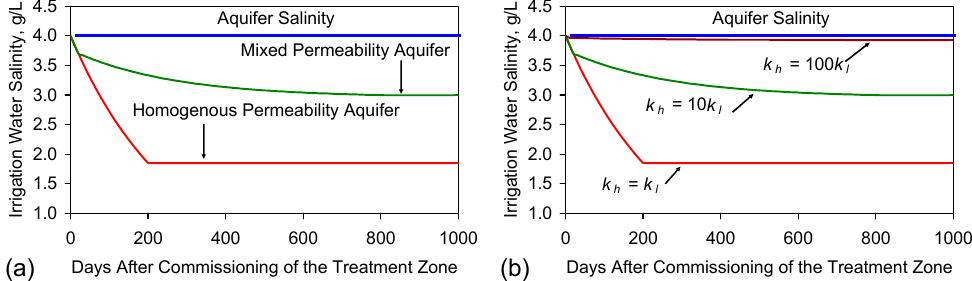
Figure G2. Expected (modeled) salinity of the irrigation water as a function of time. ( a ) The mixed permeability aquifer case illustrated in Figure G1; ( b ) Mixed permeability aquifer demonstrating the impact of changing the ratio of permeabilities between the higher permeability aquifer ( k h ) and the lower permeability aquifer ( k l ). Assumption: Average water residence time in the Aquifer Treatment Zone = 200 days when ( k h ) = ( k l ); 20 days when ( k h ) = 10( k l ); 2 days when ( k h ) = 100( k l ); Aquifer Thickness = 1 m; Rate Constant = Figure B2b. ( y + n ) = 0.